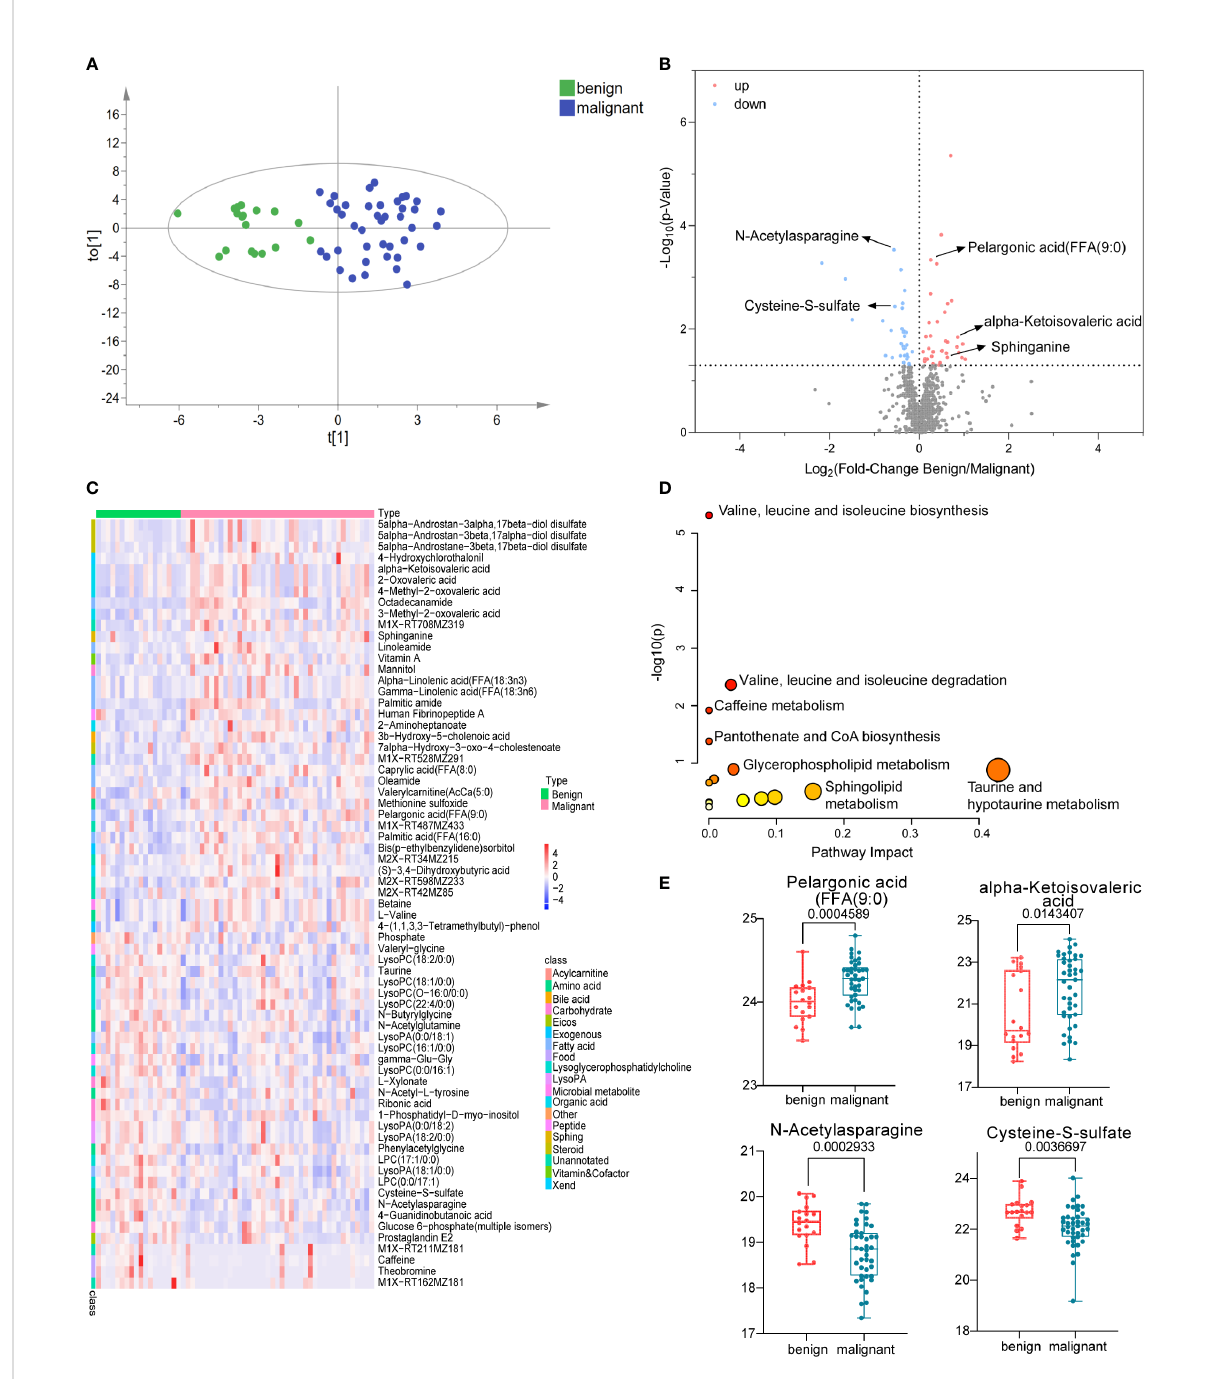
FIGURE 2 Polar metabolites in benign and malignant breast tumor group. OPLS-DA score plots of metabolites between benign and malignant group (A) . The volcano plots of metabolites, the red dots of the metabolites in the volcano plots indicated an increase and the blue dots indicate a decrease in the malignant group (B) . The relative concentration of metabolites in each sample in benign and malignant group was visualized using a heat map (C) . Metabolic pathway enrichment analysis based on KEGG database was performed to determine differentially enriched pathways between benign and malignant group (D) . Relative concentration of pelargonic acid (FFA (9:0), alpha-ketoisovaleric acid, N - Acetylasparagine, and cysteine S-sulfate in benign and malignant group (E)